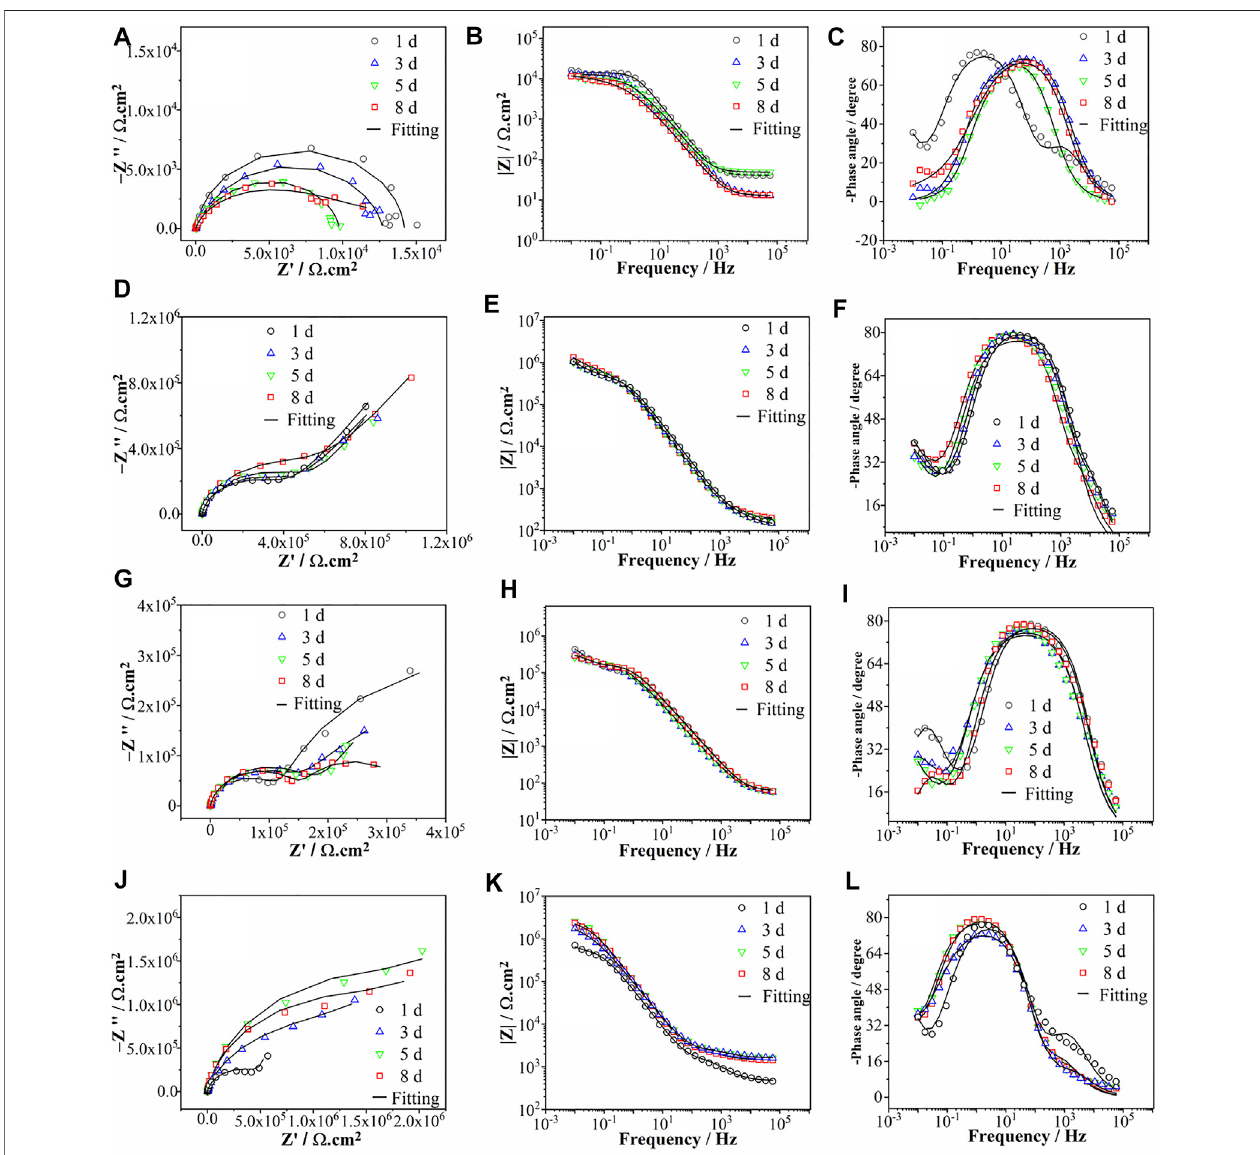
FIGURE 2 | EIS spectra of the (A – C) AAO substrate, (D – F) Li-AAO substrate, (G – I) scratched AAO/epoxy coating, and (J – L) scratched Li-AAO/epoxy coating during immersion in 3.5% NaCl solution from 1 to 8 days.